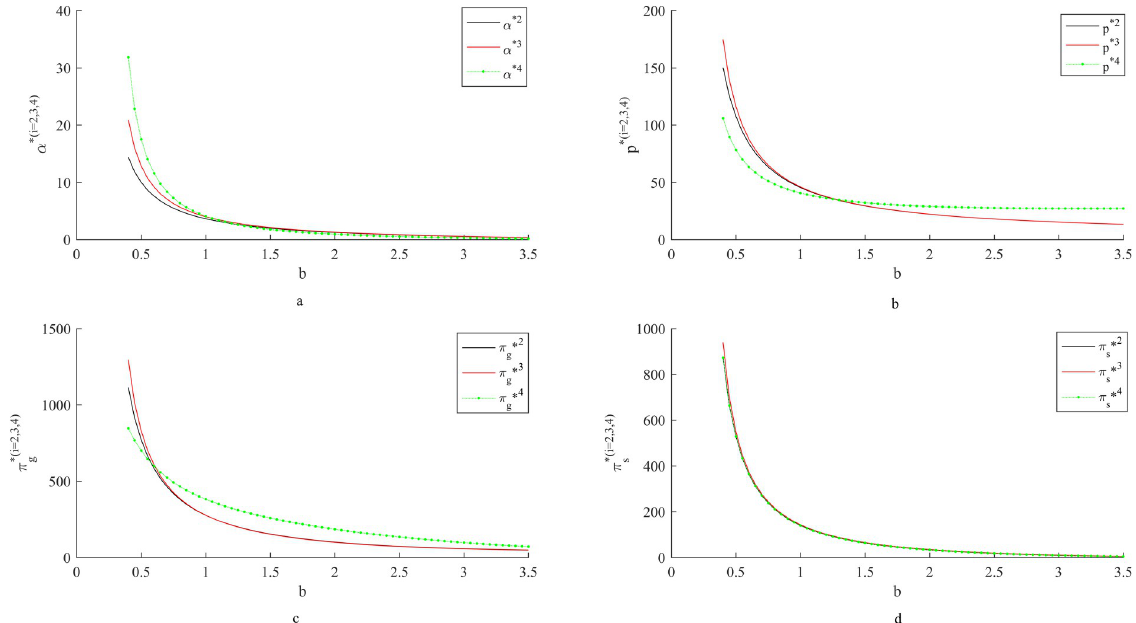
Fig 2. Influence of b on fresh-keeping decisions and